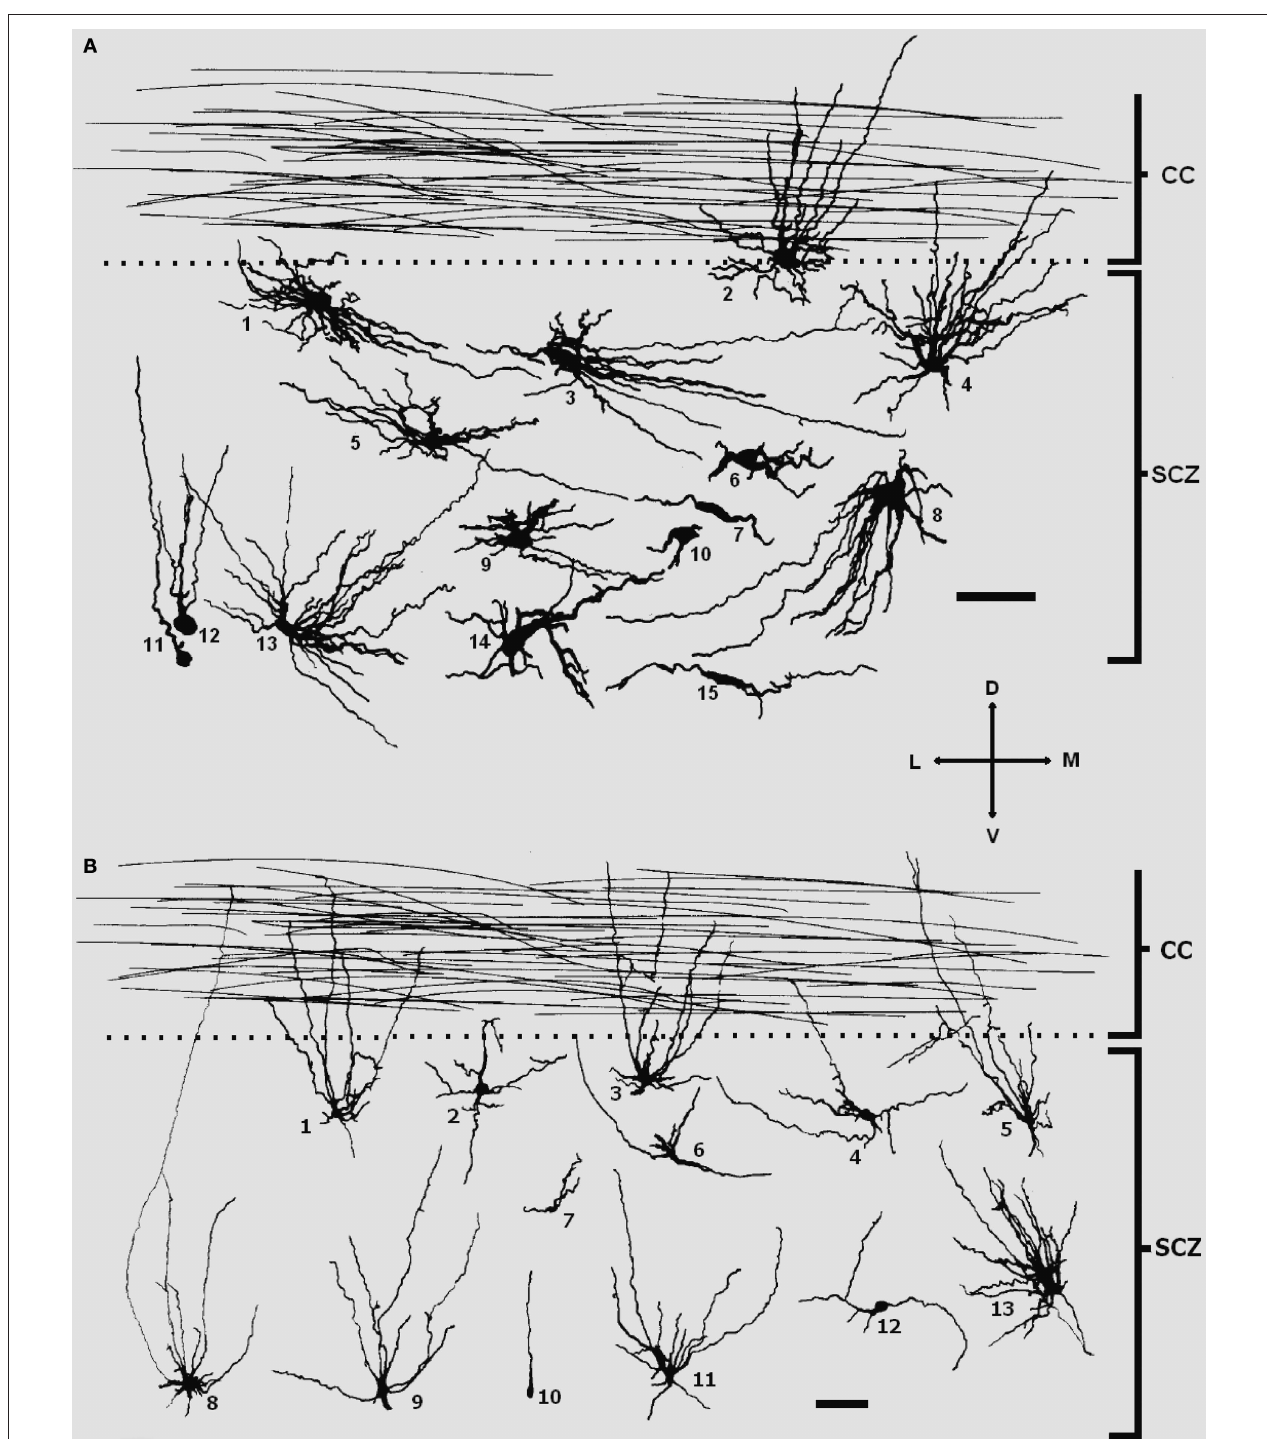
FIGURE 4 | Different types of cells in the subcallosal region of a 22-PCW (A) and a 28-PCW human fetus (B), as reconstructed by Neurolucida software. The subcallosal zone (SCZ) at both stages contain radial glial cells (B10), glia-like cells (A1, A3), migratory-like neurons (A7), immature polymorphic neurons (A6, 8, 9, 10, 12, 14,15 and B2, 4, 6, 7, 12), and region-specifi c large